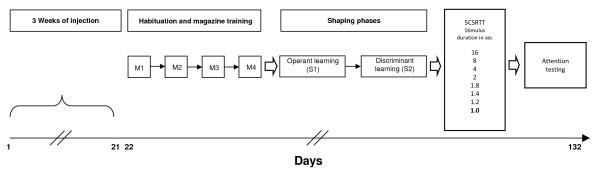
Experimental design. Following 3 weeks of EPO (5,000 IU/kg body weight intraperitoneal) versus placebo (diluent control) treatment or handling only (no-inject group), 7-week-old mice go through habituation/magazine training (M1–M4) and shaping phases (S1–S2) before starting training in the 5CSRTT. Here they move from 16 sec to the respective next phase with lower stimulus duration (8 sec and so on) upon reaching fixed criteria. Having reached criteria in the 1.0-sec phase, their attention is challenged by further shortening stimulus duration (0.8 sec).